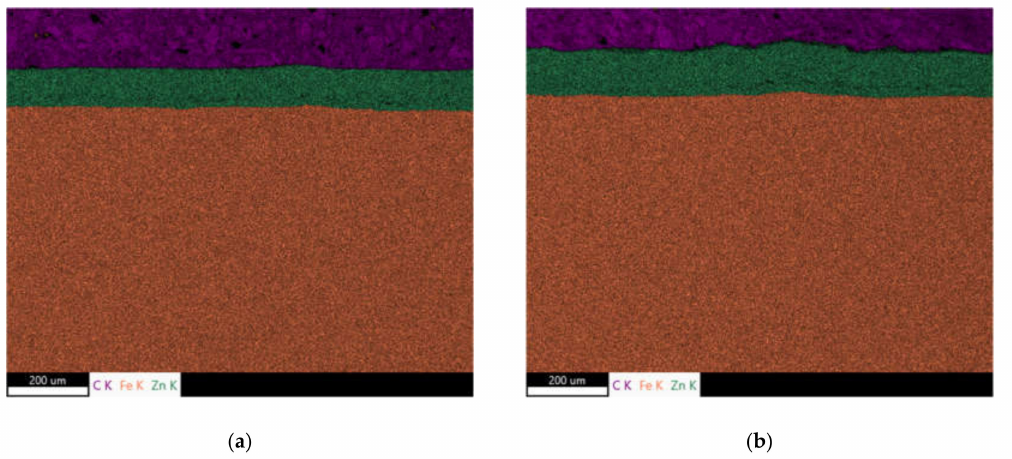
Figure 6. Chemical maps of Zn coating and steel matrix. ( a ) Coating thickness 101 ± 4 µ m, ( b ) coating thickness 144 ± 6 µ